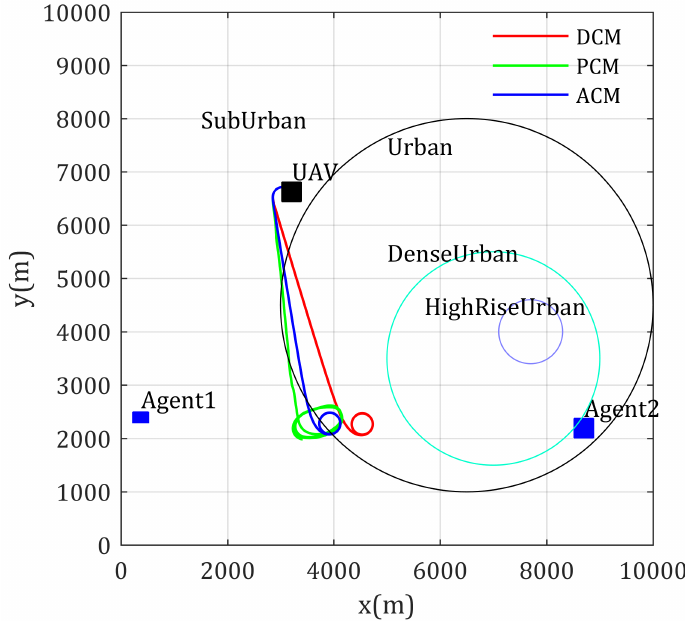
Figure 6. Paths for two static agents end-to-end communication with known channel